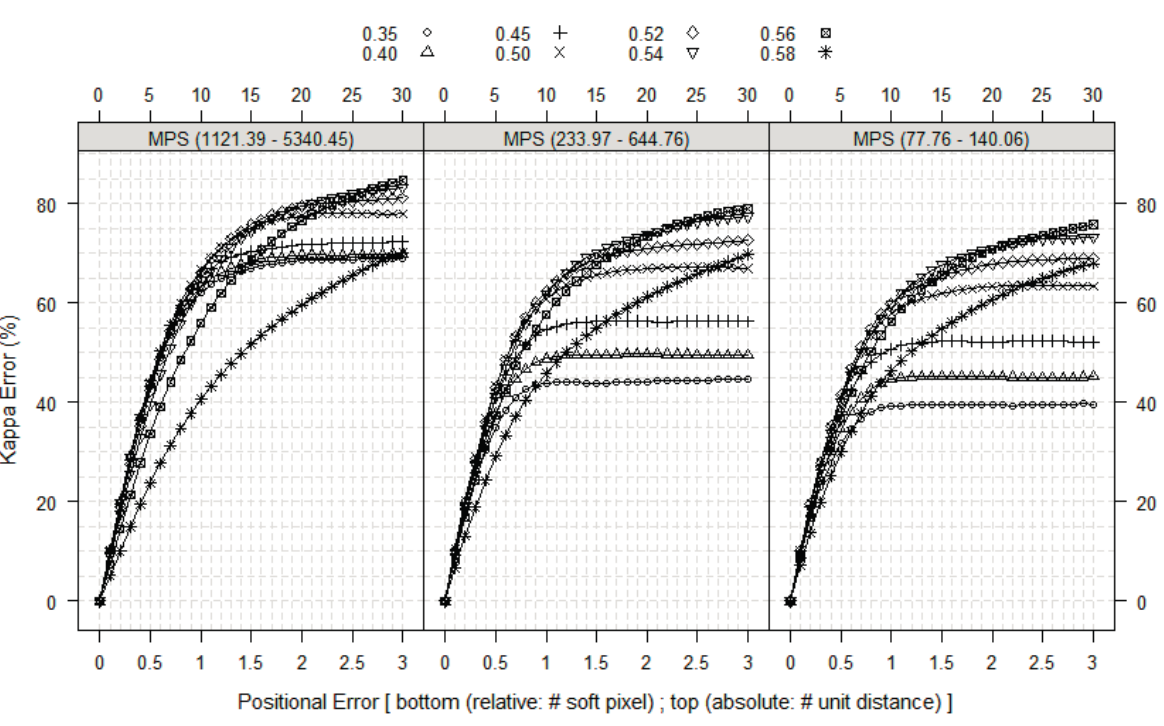
Figure 9. Impact of positional error on kappa-error at different landscape characteristics using a spatial resolution of 5 unit distance.